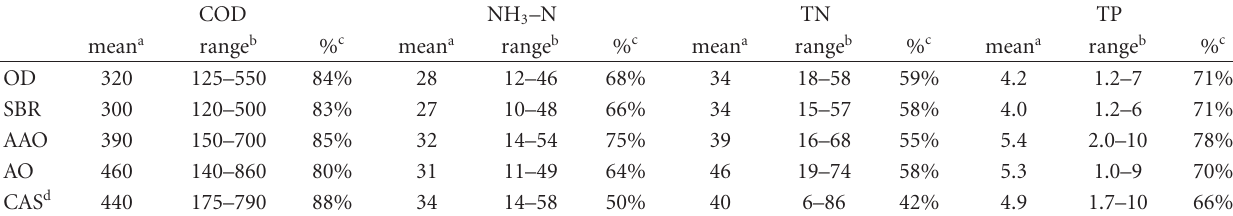
Table 2: Performance of major WWTP processes in China in 2006 (unit, mg/L).